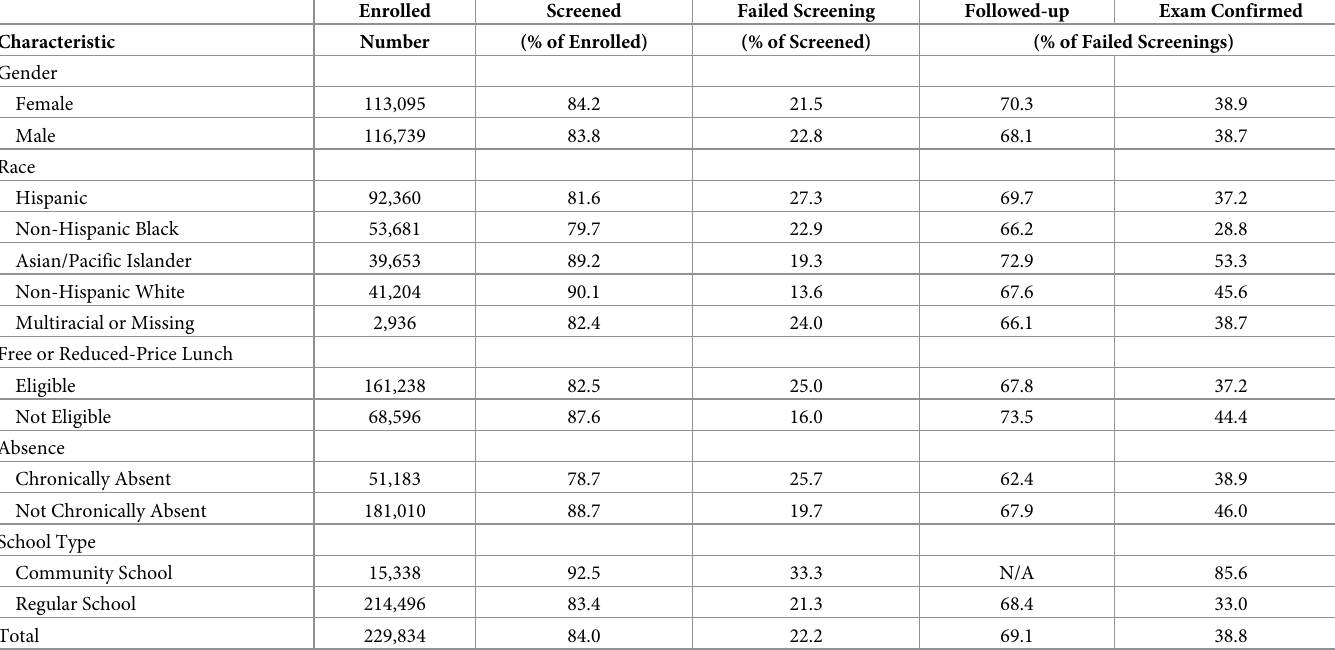
Table 4. Rates of screening, failed screenings, follow-up, and confirmed exams by student and school characteristics, among students in Pre-K through 1 st grade, 2018–19.